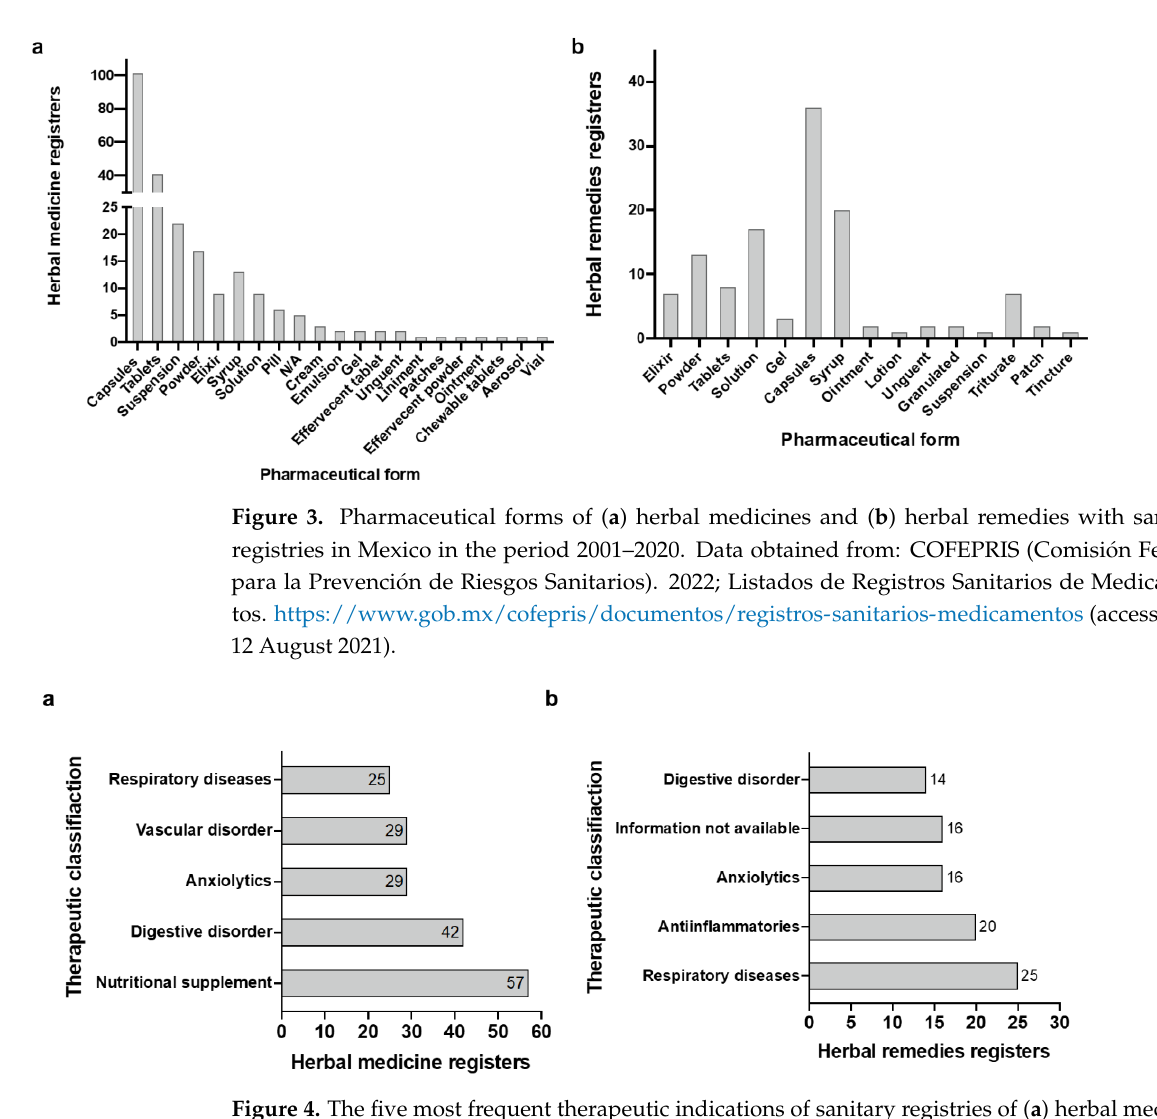
Figure 4. The five most frequent therapeutic indications of sanitary registries of (a) herbal medicine and (b) herbal remedies in Mexico during 2001 – 2020. Data obtained from: COFEPRIS (Comisión Federal para la Prevención de Riesgos Sanitarios). 2022; Listados de Registros Sanitarios de Medi- camentos. https://www.gob.mx/cofepris/documentos/registros-sanitarios-medicamentos (accessed on 12 August 2021).